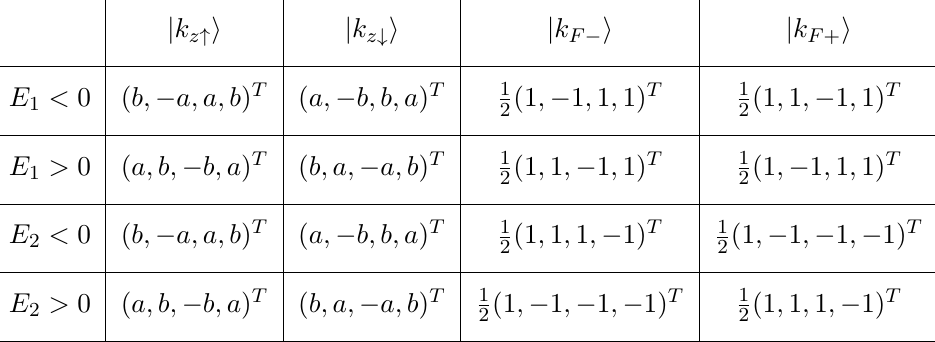
Table 1 . We use E 1 and E 2 for eigenvalues of the states along discrete circles around “Band-1” and “Band-2”. The states in the table are the ones which contribute to the nontrivial phase factor in the Berry phase. Note that here b > a > 0